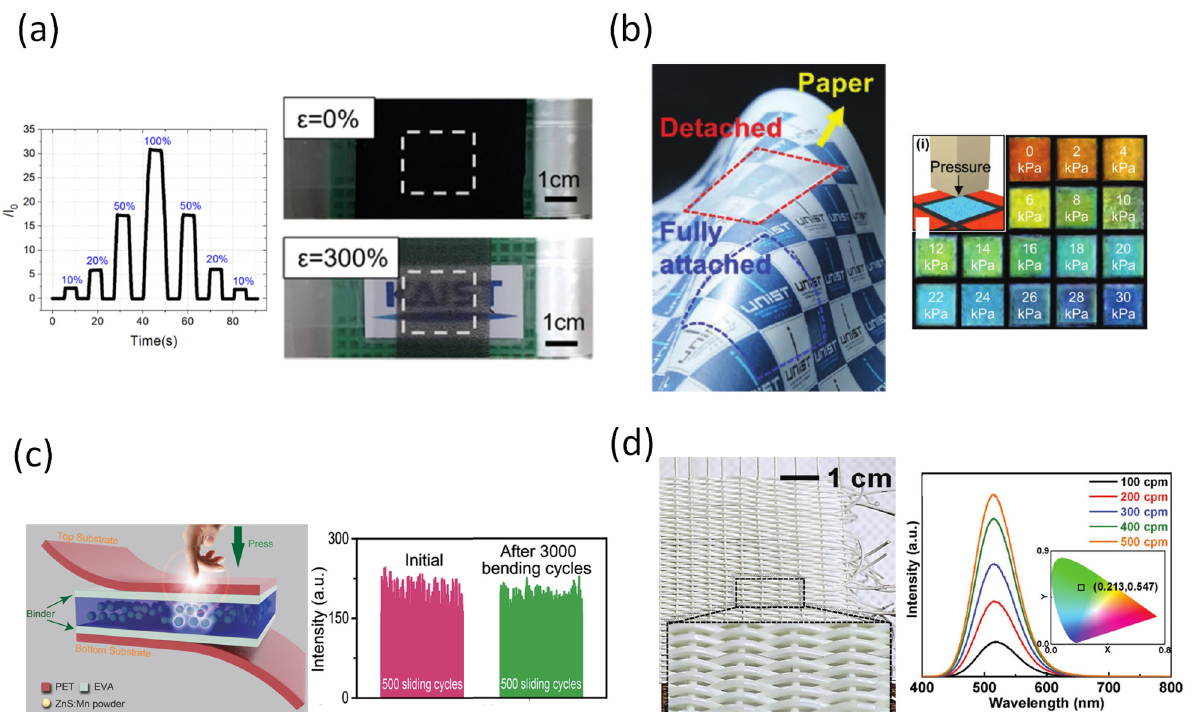
Figure 7. ( a ) Optical tactile device builds based on CNTs embedded in Ecoflex film [131]. ( b ) Adaptable and wearable photonic sensor based on shape-memory/responsive cellulose [132]. ( c ) Pressure mapping of personal handwriting device based on chemiluminescence [133]. ( d ) Self-power light-emitting fabric [134]. Table 5. Comparative of the recent optical-based